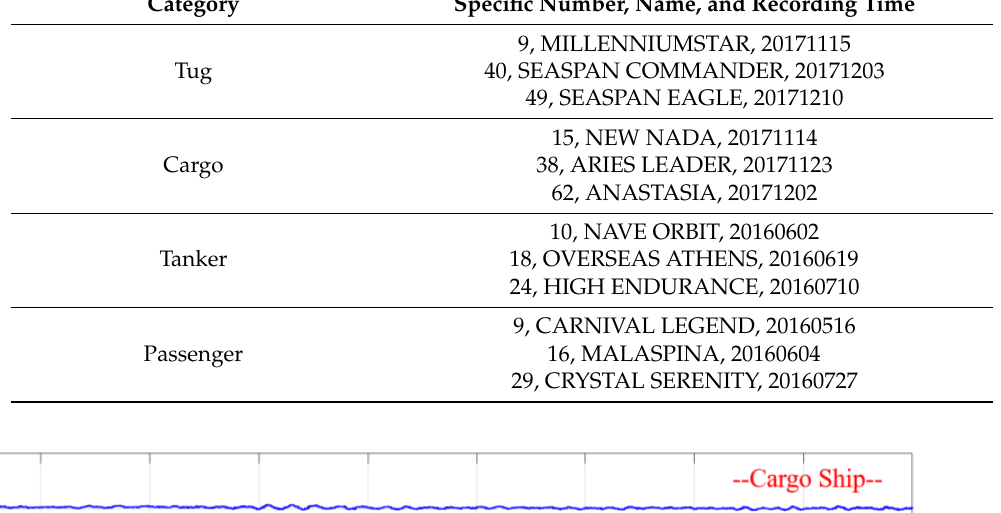
Table 1. The information of raw recordings of ships.